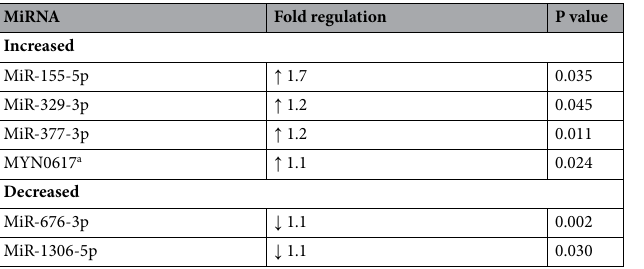
Table 2. MiRNA fold-regulation in GSAT pre- and post-exercise training. MiRNA expression was quantified as transcripts per million of total aligned miRNA Illumina reads. Fold regulation represents miRNA expression post-exercise / pre-exercise . a